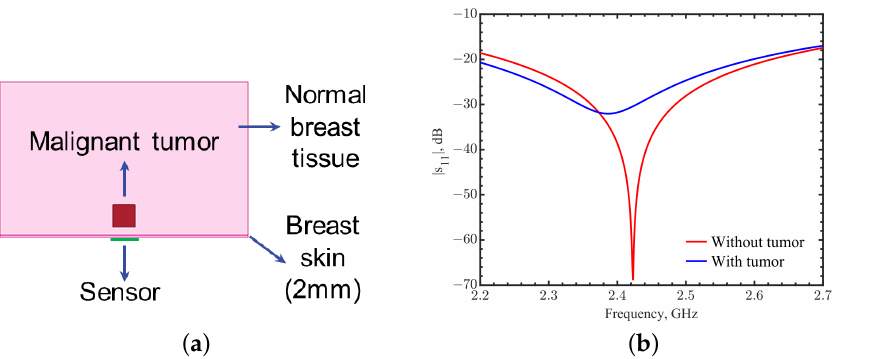
Figure 2. ( a ) Simulation setup. ( b ) Comparison of the magnitudes of reflection coefficients between the cases with and without a tumor inside.